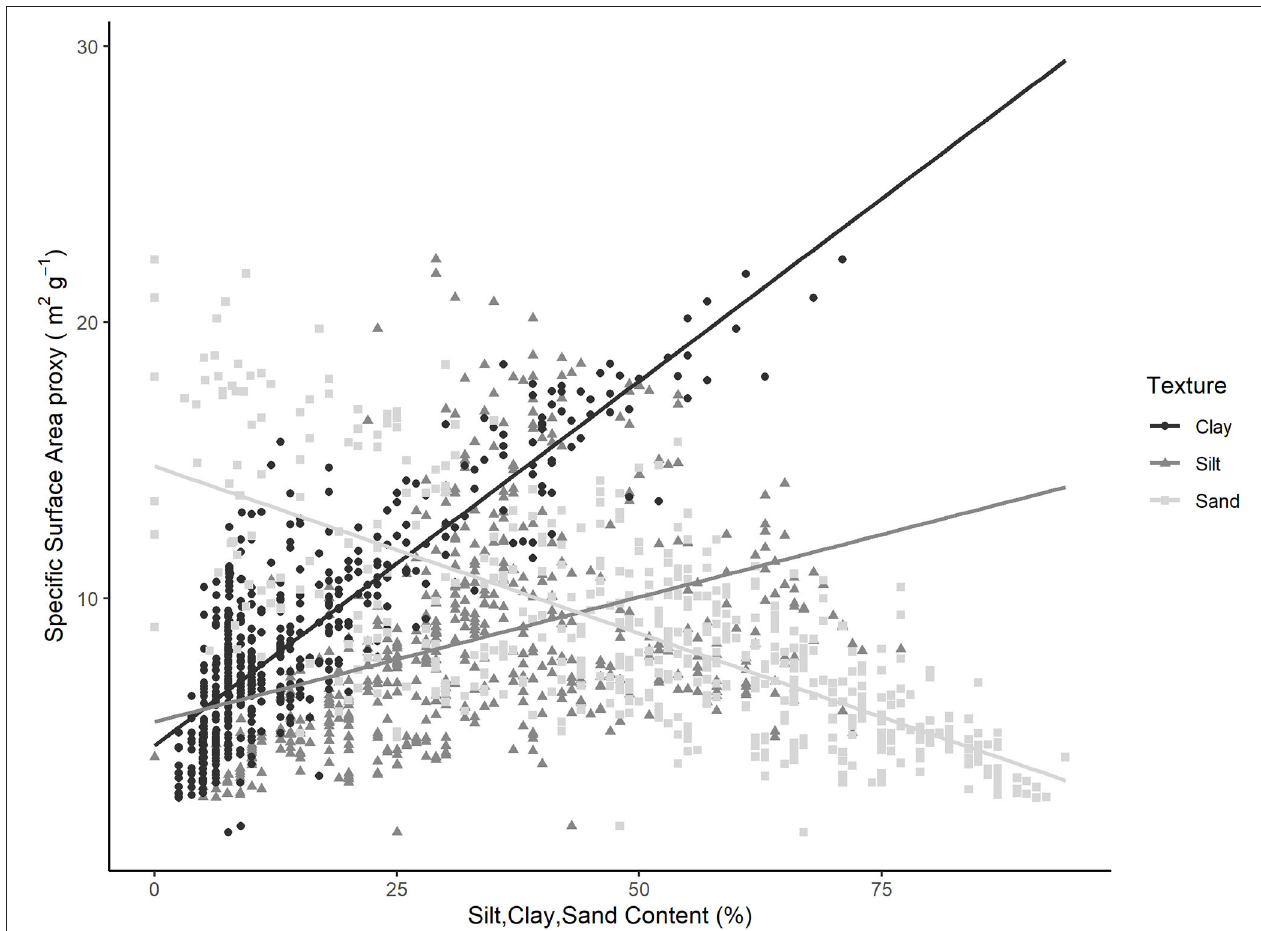
FIGURE 3 | Comparison of SSA proxy (measured using moisture loss as in Equation 2) and soil texture variables for 537 samples collected from orchards, vineyards, and under native vegetation. Each soil sample has three points on the figure: one for Clay % vs. SSA proxy ( p < 0.001; R 2 : 0.74), a second for Silt % vs. SSA proxy ( p < 0.001; R 2 : 0.14), and a third for Sand % vs. SSA proxy ( p < 0.001; R 2 :